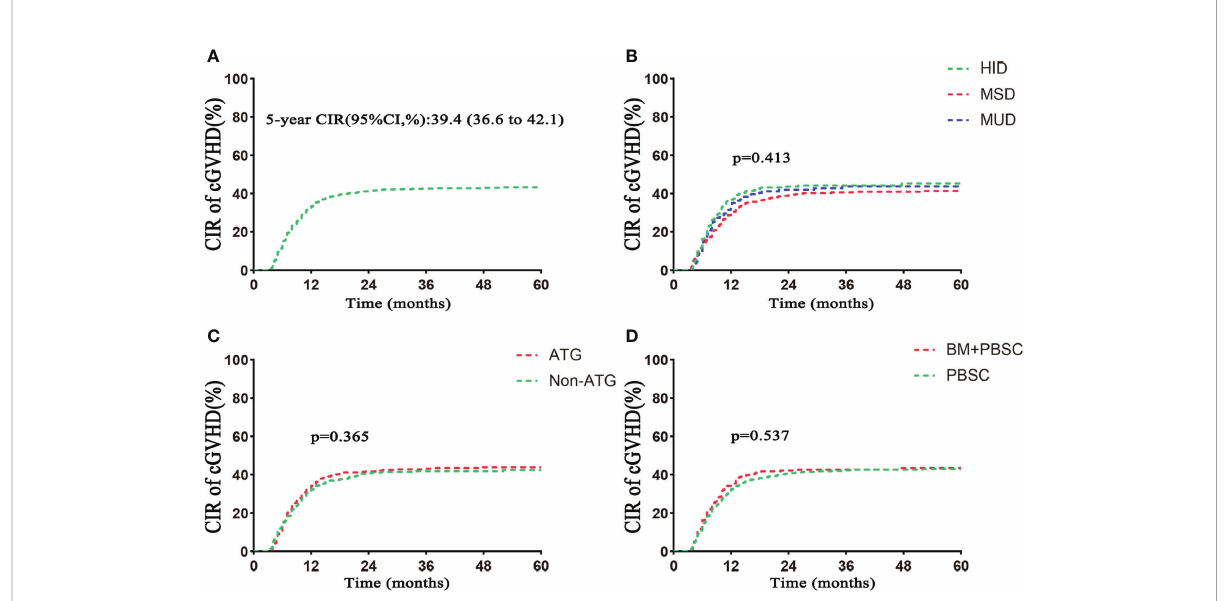
FIGURE 2 Cumulative incidence of cGVHD. (A) Cumulative incidence of cGVHD in the total population. (B) Cumulative incidence of cGVHD based on donor type. (C) Cumulative incidence of cGVHD based on ATG. (D) Cumulative incidence of cGVHD based on grafts. CIR, cumulative incidence rate. Follow – up started from transplantation.